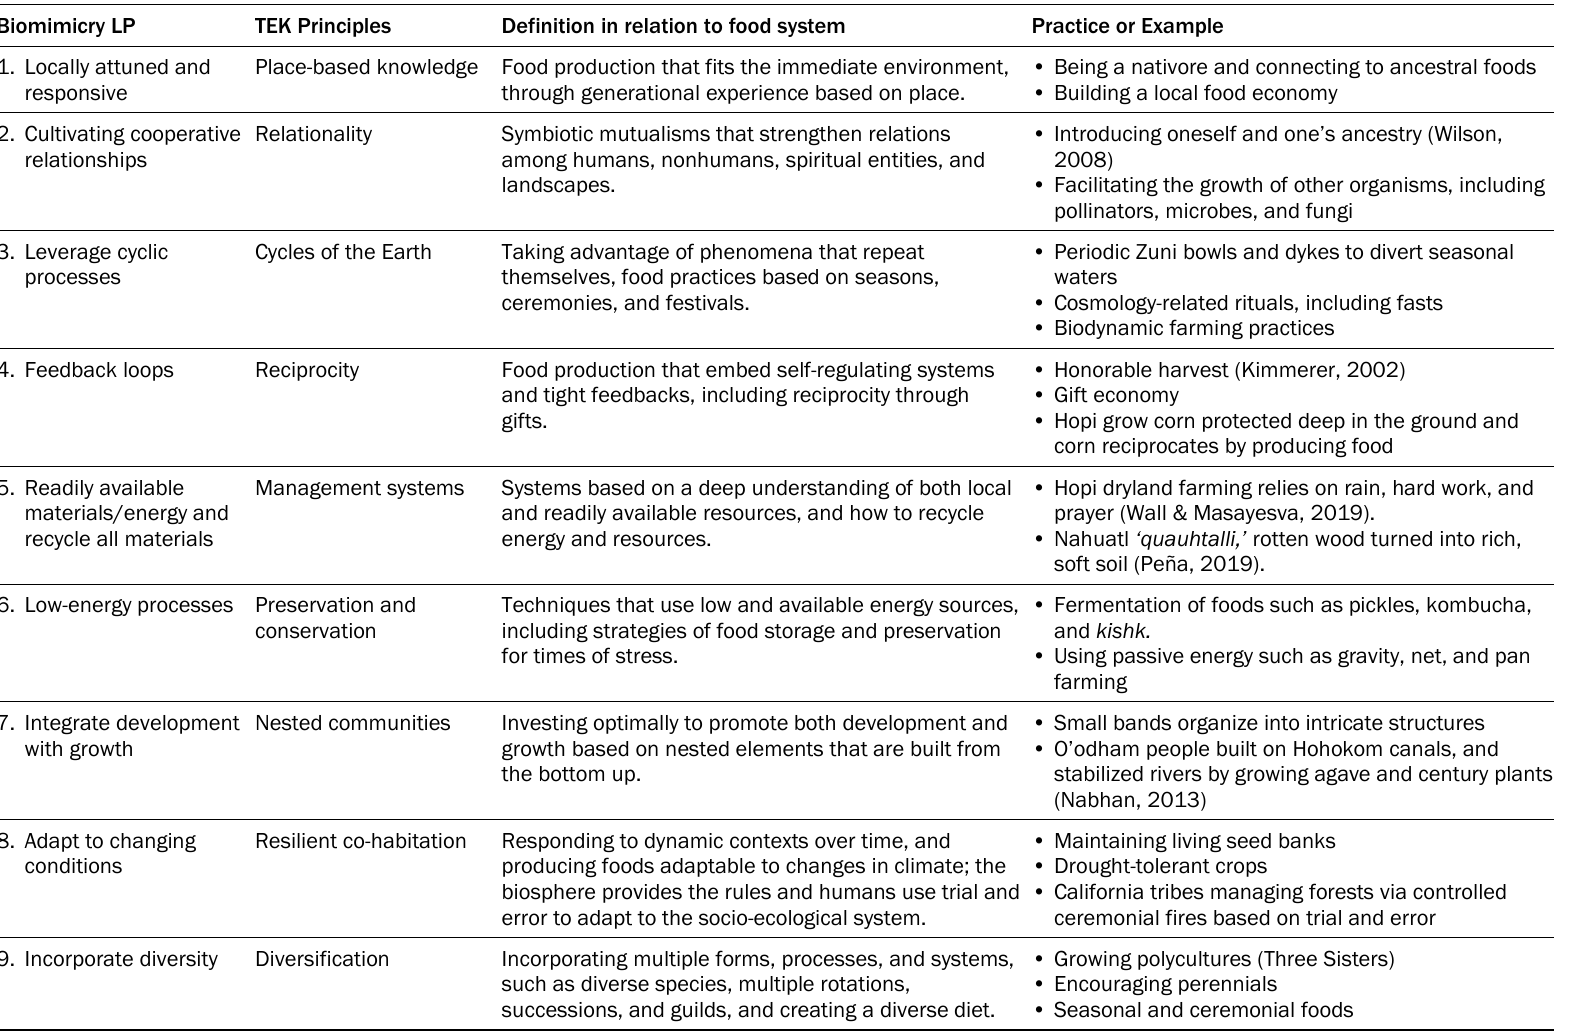
Table 3. LPs and TEK Definitions in Relation to Food Systems and Corresponding Examples Numbers correspond to numbers in the discussion